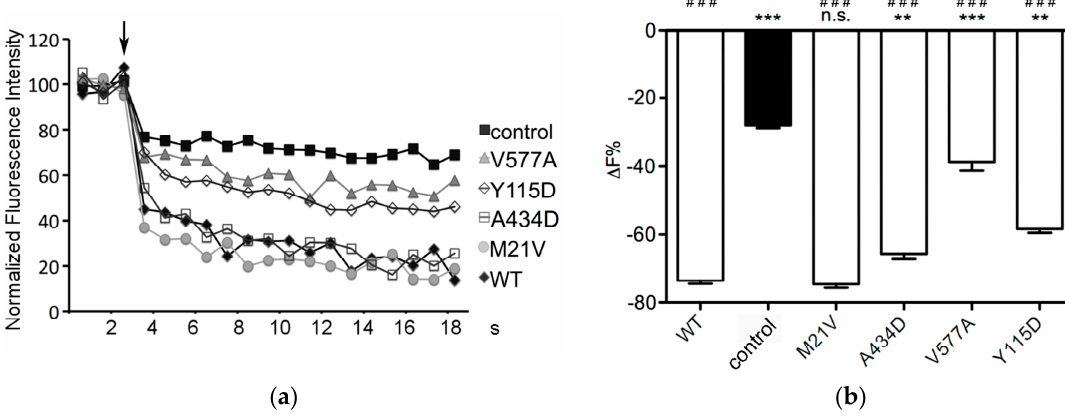
Figure 1. Functionality of wild type pendrin and four pendrin variants identified in Austrian deaf patients with enlarged vestibular aqueduct (EVA). ( a ) Representative measurements of intracellular fluorescence intensity in HEK 293 Phoenix cells transfected with wild type (WT) or mutated pendrin and the iodide sensor enhanced yellow fluorescent protein (EYFP) H148Q;I152L or EYFP H148Q;I152L alone (control) and bathed in chloride- or iodide-containing solutions. The arrow indicates the addition of iodide to the extracellular solution. Fluorescence intensity was normalized for the average of fluorescence intensity in the chloride-containing solution; ( b ) Percentage of fluorescence decrease ( Δ F%) determined over the experimental period (19 s) in cells expressing the indicated pendrin variants and in control cells. Error bars represent SEM. *** p < 0.001, ** p < 0.01, n.s.: not statistically significant compared to wild type; ### p < 0.001 compared to control, one-way ANOVA with Bonferroni’s multiple comparison post-test. 36 ≤ n ≤ 107 independent measurements collected in 3–9 independent experiments.